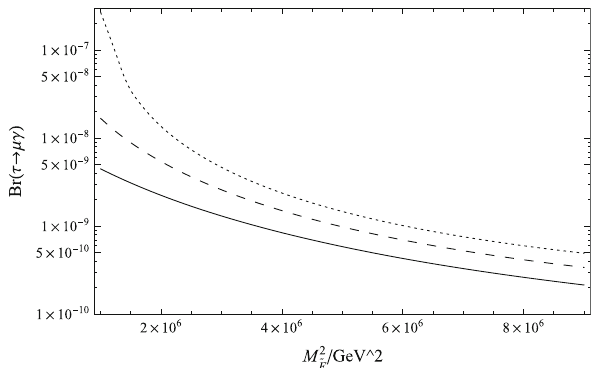
Fig. 12 With L l = 0 . 7 ( 1 . 0 , 1 . 3 ) , the branching ratios of τ → μγ versus parameter M 2 ˜ are plotted by the dotted, dashed and solid lines E respectively